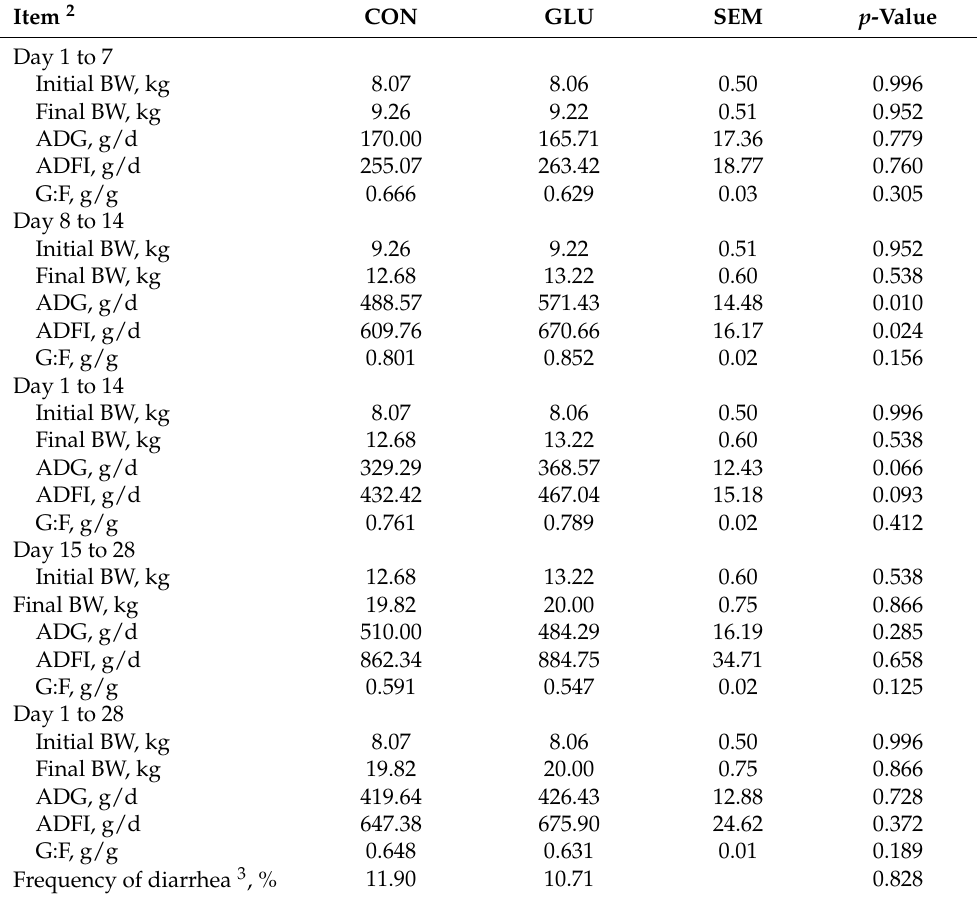
Table 3. Effects of dietary treatments on growth performance of weaned pigs 1